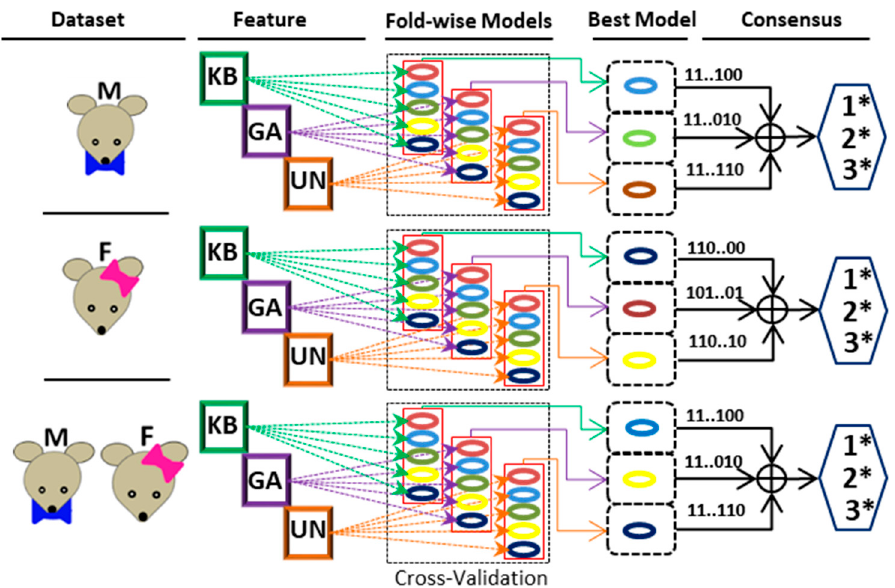
Figure 2. A schematic diagram depicting the underlying consensus strategy for S-PALM prediction.